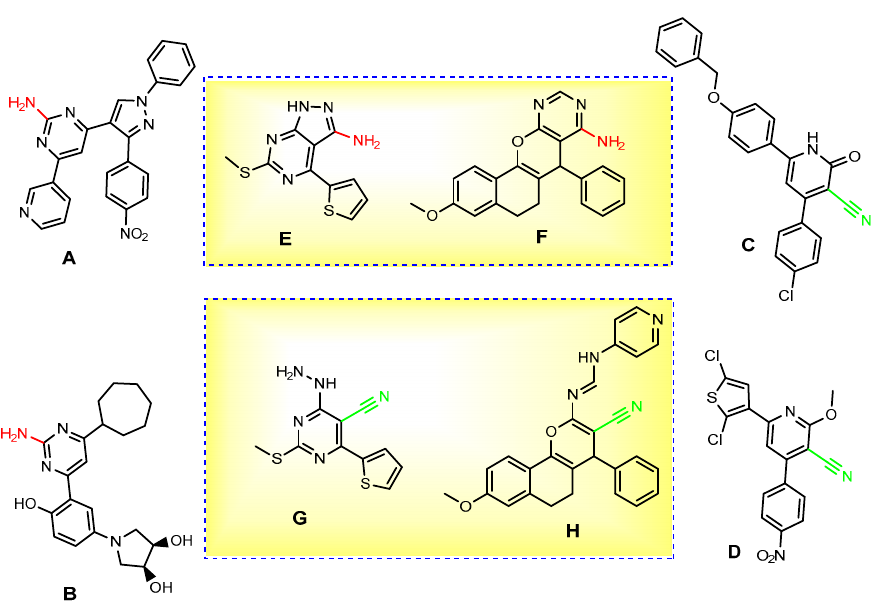
Figure 2. Previously reported cytotoxic compounds tethered with amino ( A , B , E , F ) or cyano ( C , D , G , H ) groups.